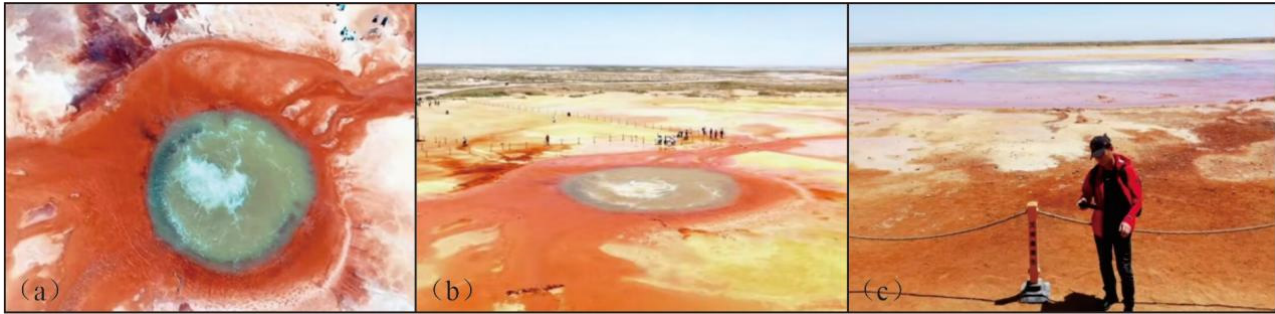
Figure 10. Schematic diagram of AK spring site visit. ( a ) AK spring top view. ( b ) AK spring 45° top view. ( c ) AK spring flat view.